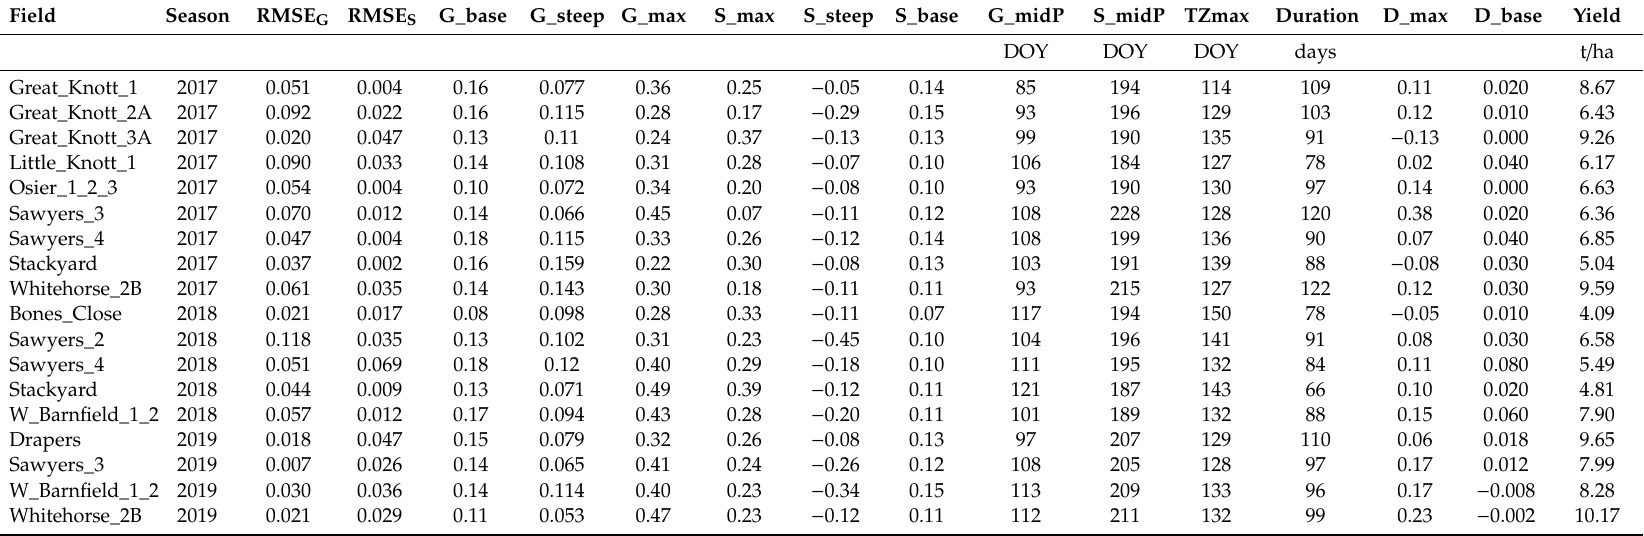
Table 3. Values of derived parameters (linear scale), yield data, and the root mean standard error of the growth (RMSE G ) and maturation (RMSE S ) stages, for each of the winter wheat fields in 2017, 2018, and 2019. Note: day-of-year, DOY.